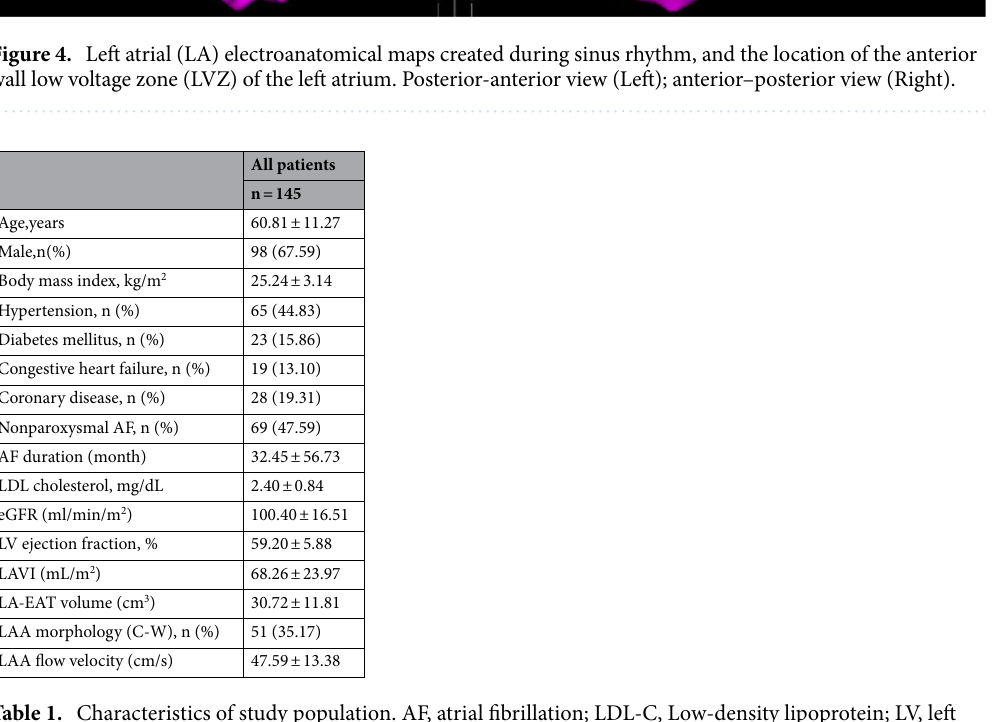
Table 1. Characteristics of study population. AF, atrial fibrillation; LDL-C, Low-density lipoprotein; LV, left ventricular; LAVI, left atrial volume index; LA, left atrial; EAT, Epicardial adipose tissue; LAA, Left atrial appendage; C-W, chicken-wing